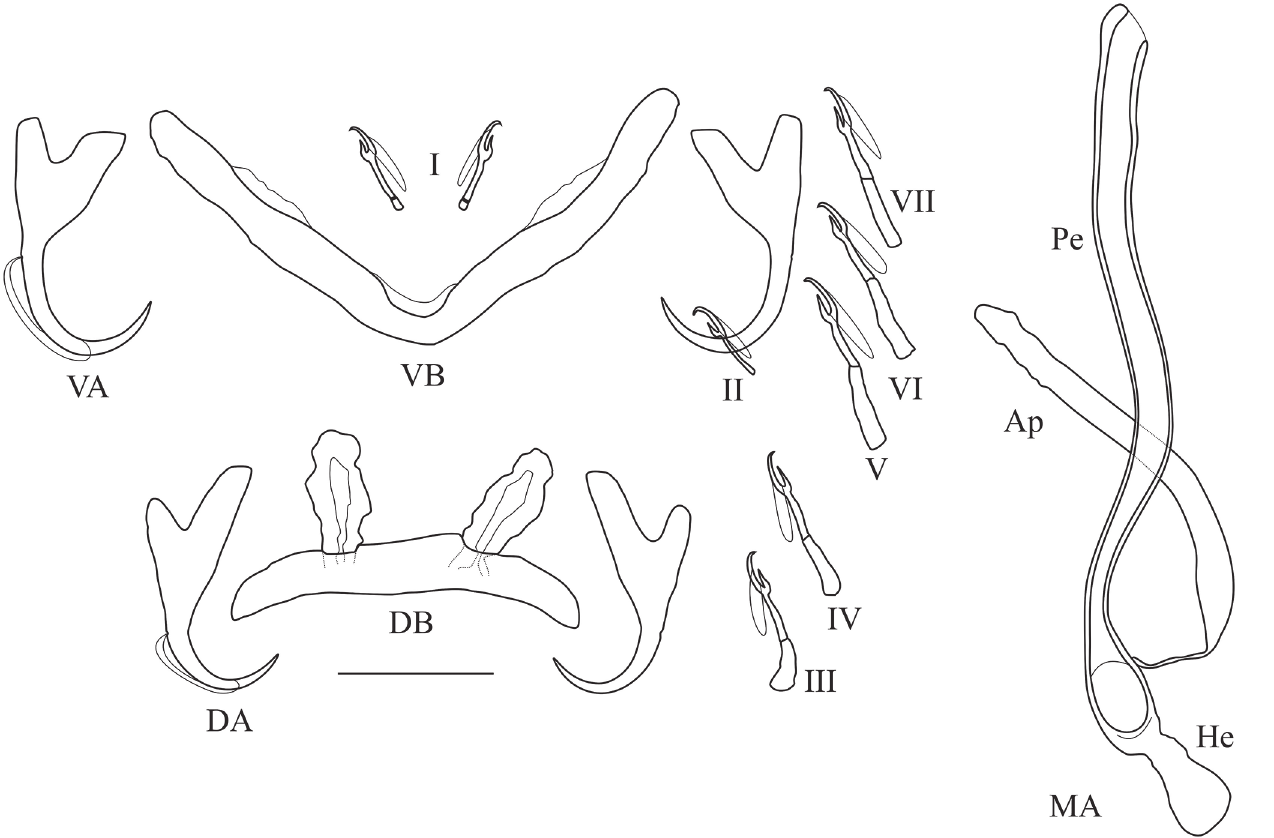
Fig 12. Haptoral and genital hard parts of Cichlidogyrus georgesmertensi sp. nov. (Ap) accessory piece (DB) dorsal transverse bar, (DA) dorsal anchor, (He) heel, (MA) male apparatus, (Pe) penis, (VB) = ventral transverse bar, (VA) ventral anchor, (I) to (VII) uncinuli, scale bar = 20 μ